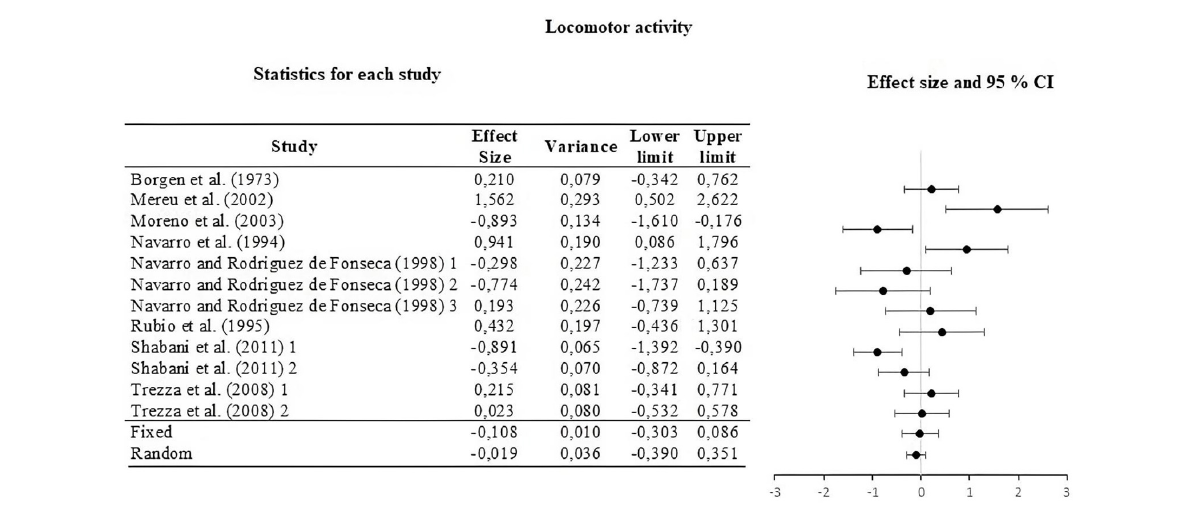
FIGURE3 Forest plot of the effect sizes and estimated confidence intervals of the UAs that evaluated locomotor activity. For the integrated effect size Cohen’s d was used. The lines indicate the effect sizes of each UA and its corresponding 95% confidence intervals. The last two lines represent the result under a fixed and random effect model, respectively. The lower and upper limits and the variance of each UA are